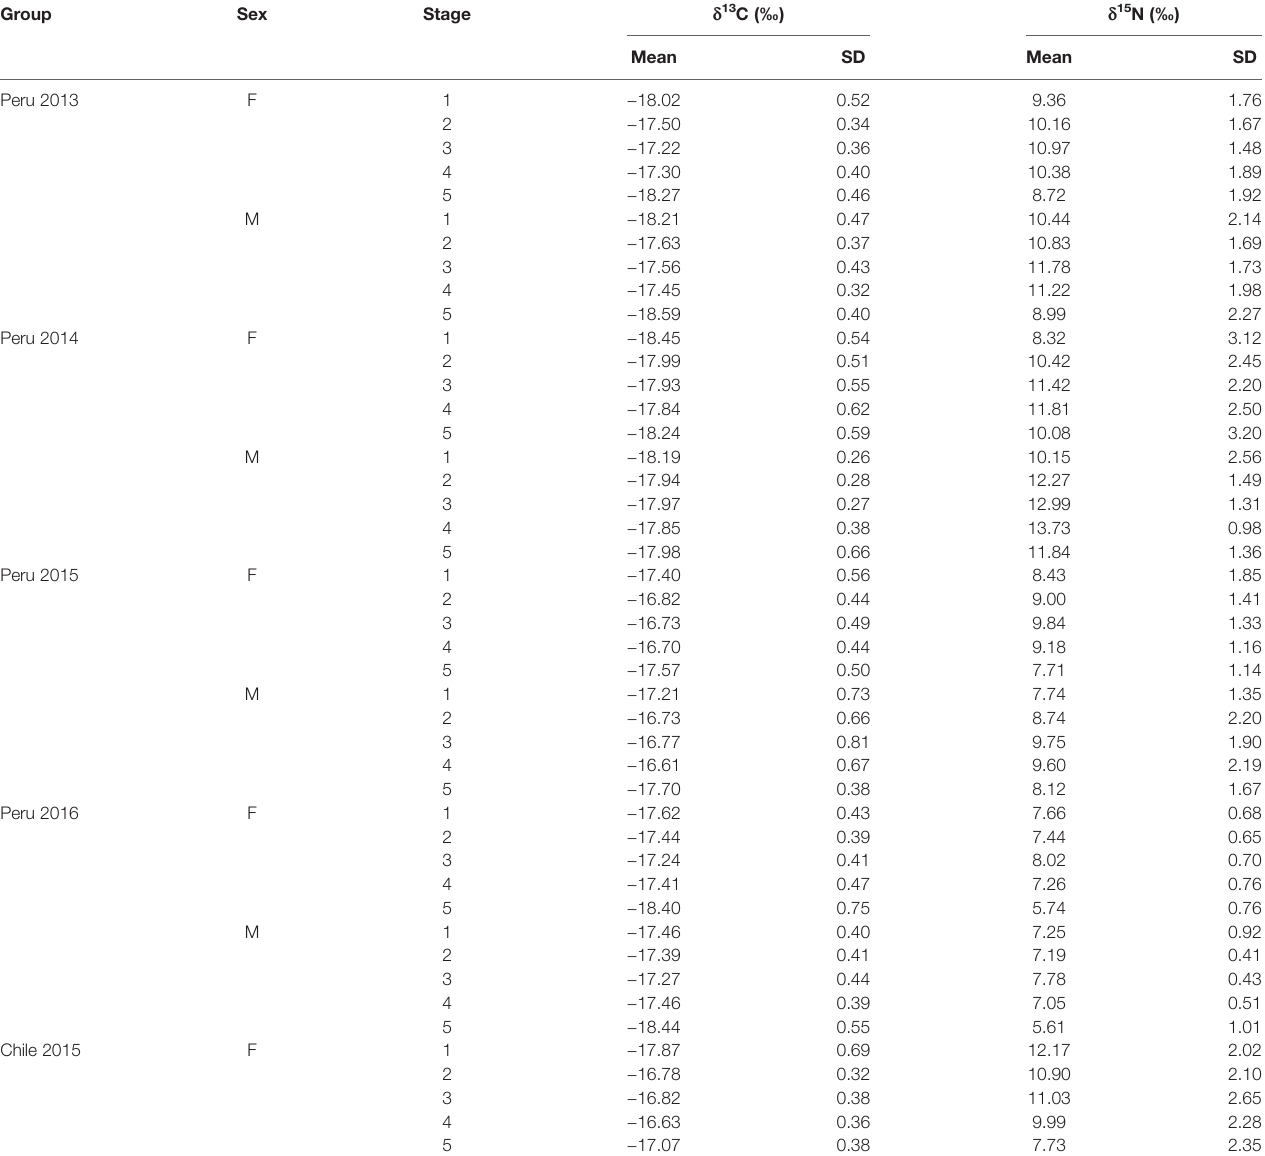
TABLE 3 | The summary of isotopic values in lower beaks for D. gigas . Group Sex Stage d 13 C ( ‰